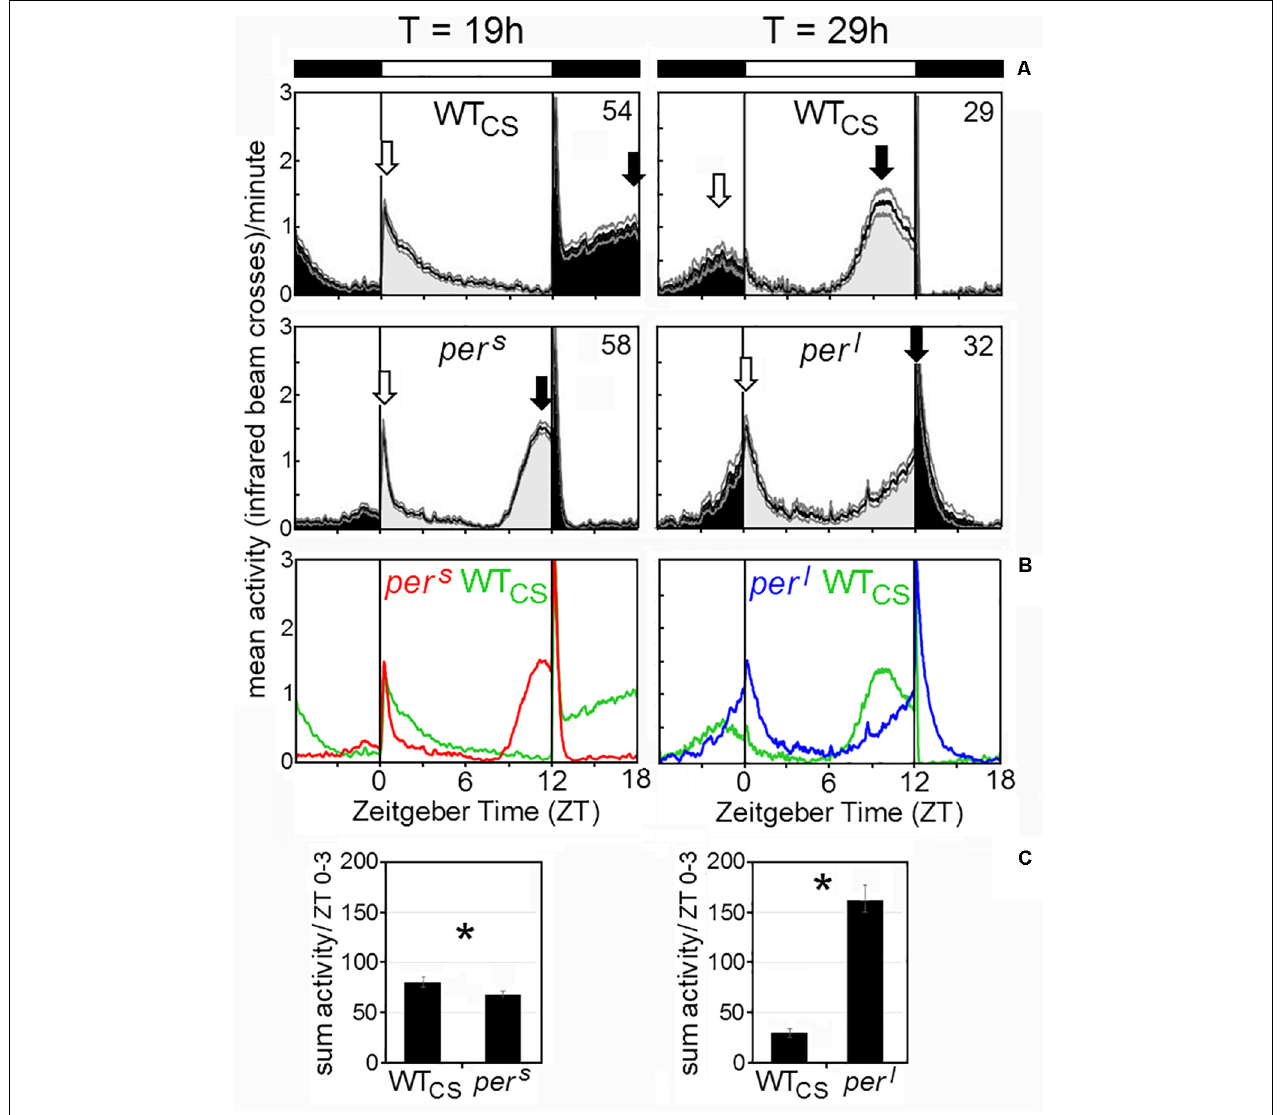
FIGURE 6 | Average activity profiles of wildtype (WT CS ) and period mutant ( per s , per l ) flies under T-cycles of 19 and 29 h. (A) : The flies show a bimodal activity pattern with morning (open arrow) and evening (closed arrow) activity bouts. In wildtype flies, morning and evening activity are delayed under 19 h T-cycles, while they are advanced under 29 h T-cycles. In per s and per l mutants the timing of morning and evening activity under 19 h T-cycles and 29 h T-cycles, respectively, resembles the timing in wildtype flies under 24 h cycles (compare Figure 1 ). (B) : Overlay of the average activity profiles of per s , WT CS and per l flies, showing the different phases of the evening activity bout and the different activity levels during morning activity. (C) : Sum of activity (beam crosses) during the first 3 h (ZT0-3) after lights-on for all fly strains. Significant differences to WT CS flies are indicated by asterisks.